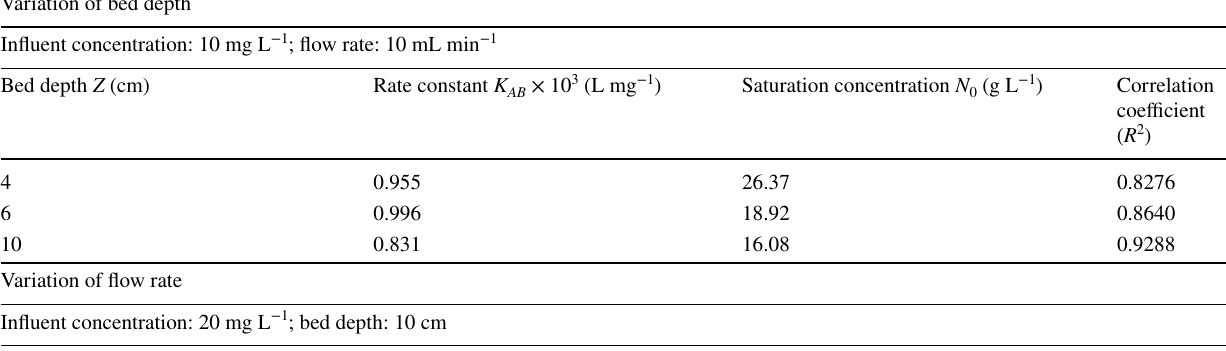
Table 3 Model parameters for Bohart–Adams model Variation of bed depth